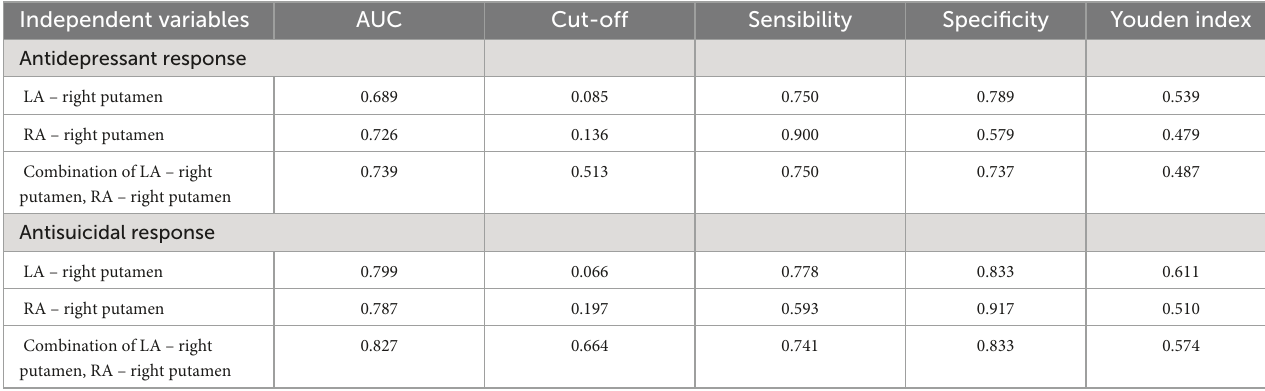
TABLE 3 Results of ROC curve analysis of antidepressant and antisuicidal response at 24 h after six ketamine infusions. Independent variables AUC Cut-off Sensibility Specificity Youden